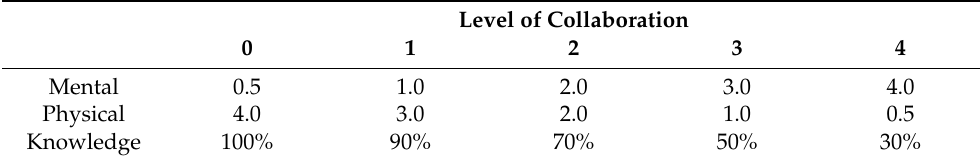
Table 6. Description of LoC with their influence on the model.